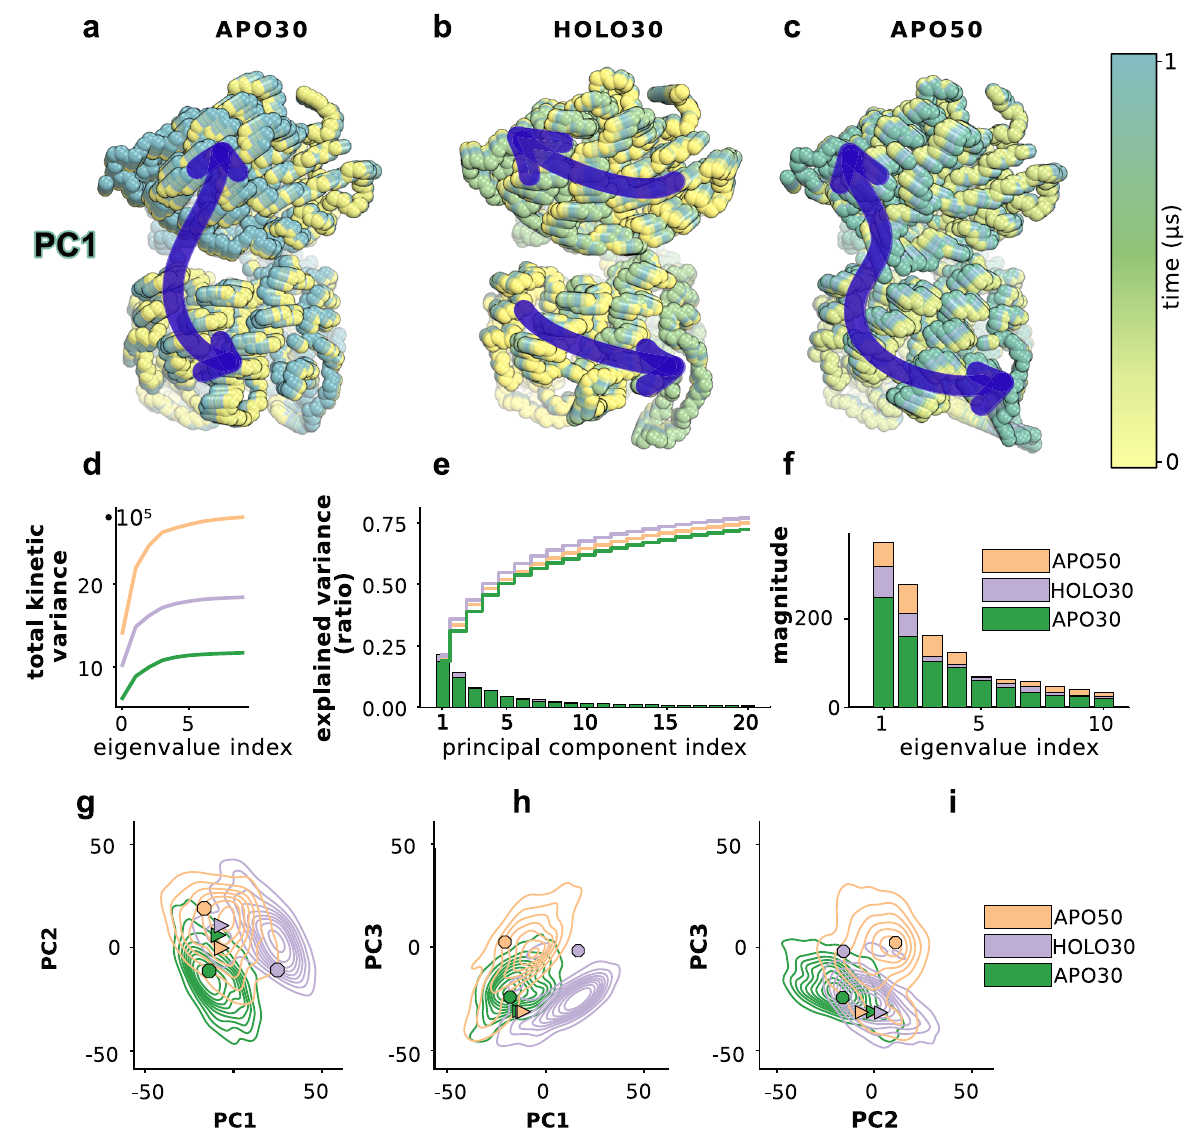
Fig.5|Collectiveproteinmotions. Essentialmotionsofthe apo30 ( a ), holo30 ( b ), and apo50 ( c ) trajectories obtained by projecting each trajectoryonto the fi rst the principal component. The overlay of 100 structures (one every 10ns) reproduces themotiondescribedbytheprincipalcomponentover1 µ stimeofeachtrajectory. The essential dynamics differ: apo30 and holo30 describe two very different motions,the fi rstbeing thecharacteristichingemotion,whichchangesintoatwist of one domain relative to the other. The collective motions described by PC1 in